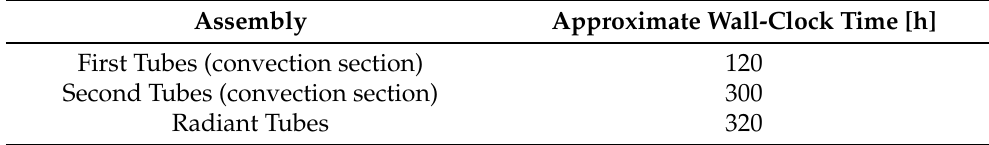
Table 10. Breakdown of wall-clock time for Waterside simulation.